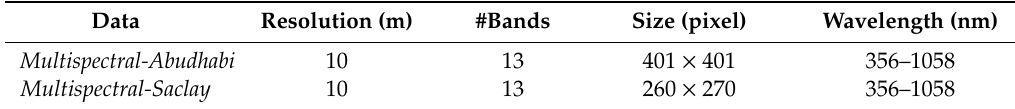
Table 1. Description of multispectral datasets (italic characters are the name of datasets).